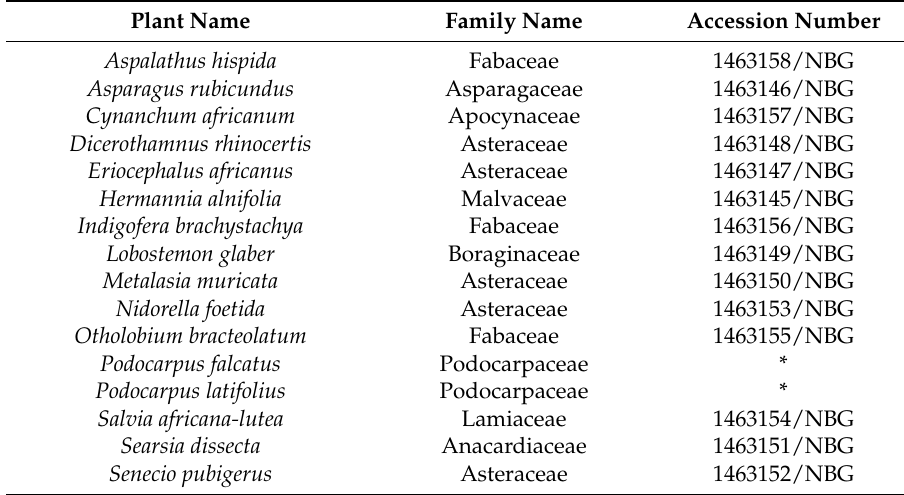
Table 3. The collected plants and their accession